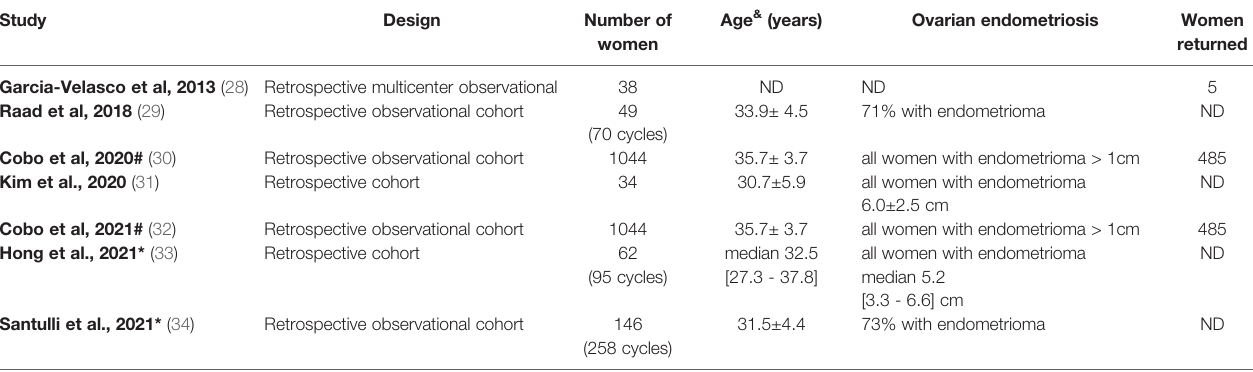
TABLE 3 | Oocyte vitri fi cation and warming in cases with endometriosis.